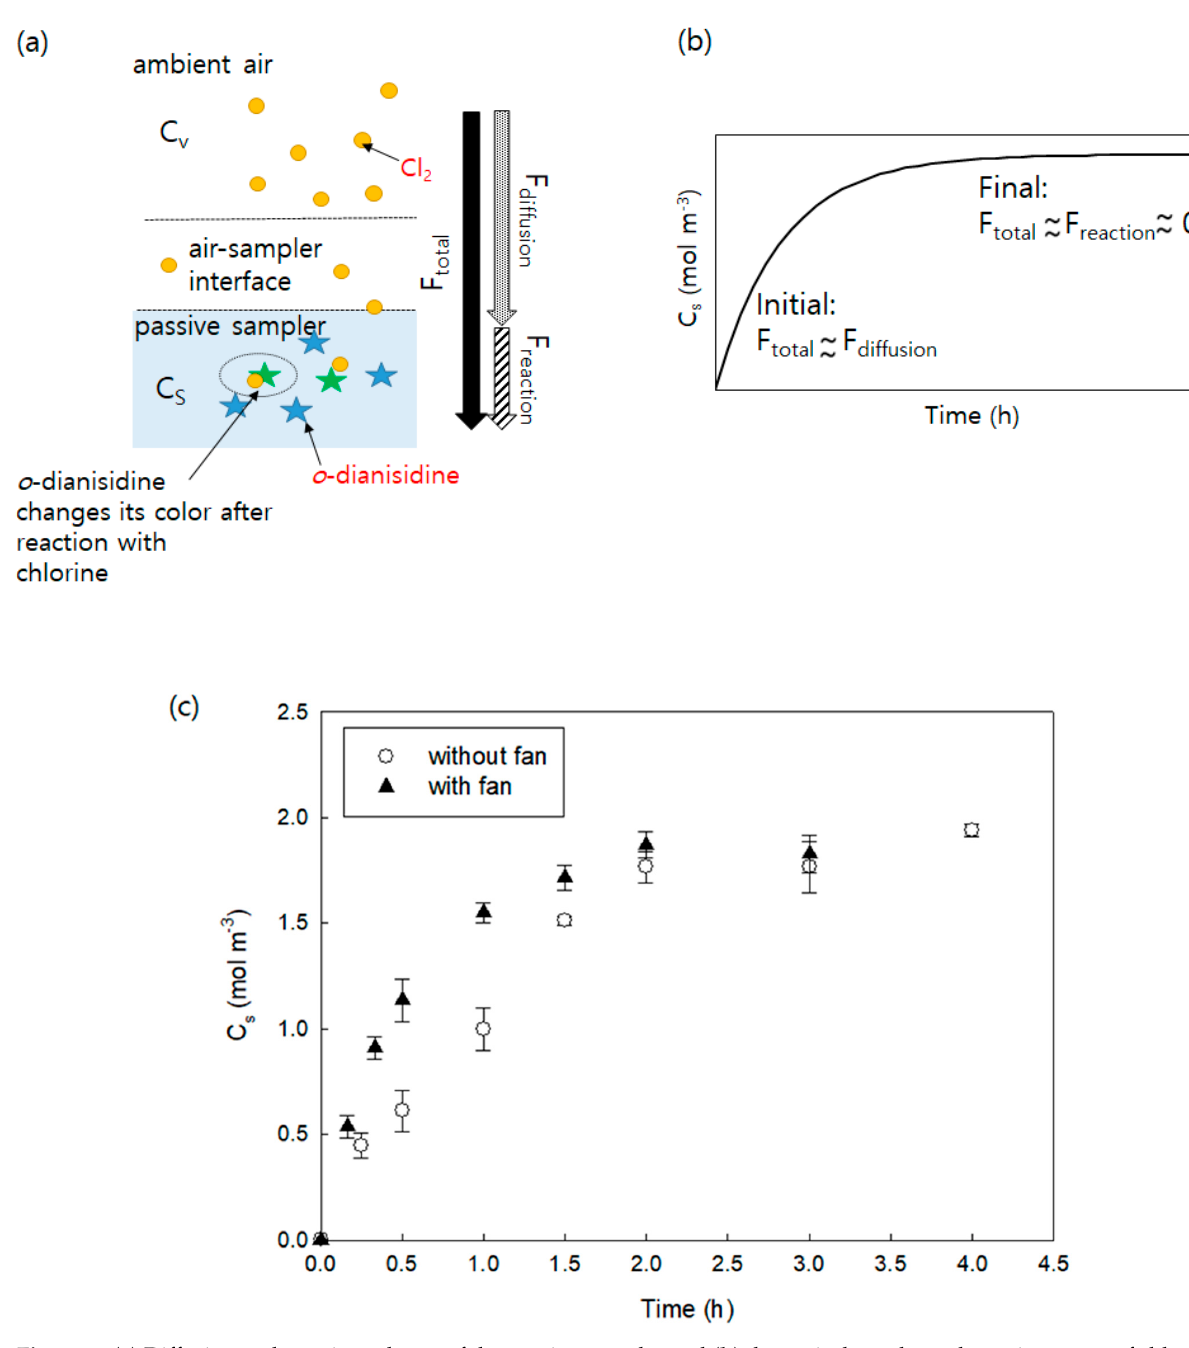
Figure 2. ( a ) Diffusion and reaction scheme of the passive sampler and ( b ) theoretical uptake and reaction curve of chlorine gas for the passive sampler. ( c ) Changes of C s (chlorine mass reacted with o -dianisidine per unit volume of passive samplers) with time. Error bars represent the standard deviations of triplicates.